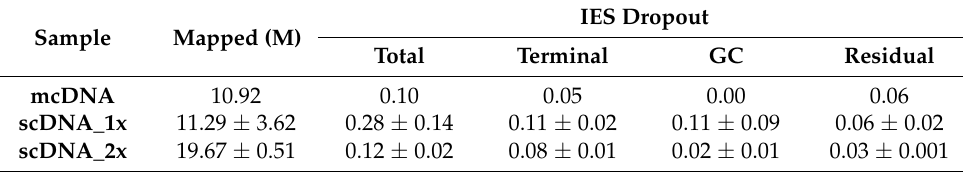
Table 2. Quantitative analysis of IES dropout. Total dropout . Fraction of all known IES loci ( n = 44,928) with read coverage equal to or lower than 20. Terminal dropout . Fraction of all known IES loci located within 30 kb from either scaffold ends ( n = 9986) with a read coverage equal to or lower than 20. GC dropout. IES dropout unexplained by either terminal or residual dropout is assumed to results from the positive GC Bias. Residual dropout . IES dropout unrelated to amplification biases found in the mcDNA sample. Mapped pairs, total number of read pairs mapped (in millions). mcDNA, mass culture DNA sequencing. scDNA, single-cell DNA sequencing. scDNA_1x, scDNA samples with approximately the same number of mapped reads compared to the mcDNA sample (5 × 10 6 < n ◦ mapped reads < 15 × 10 6 , n = 6). scDNA_2x, scDNA samples with approximately twice as many mapped reads compared to the mcDNA sample (n ◦ mapped reads > 19 × 10 6 , n = 4). Mapped, mapped read pairs